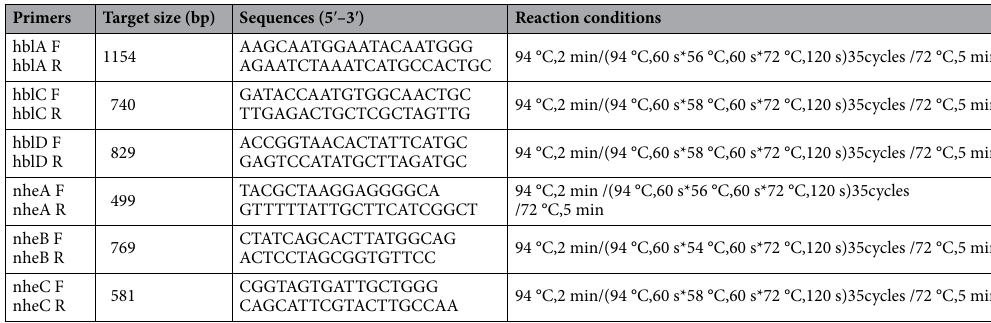
Table 6. Primer names and sequences, target size and PCR conditions for enterotoxin genes detection 58